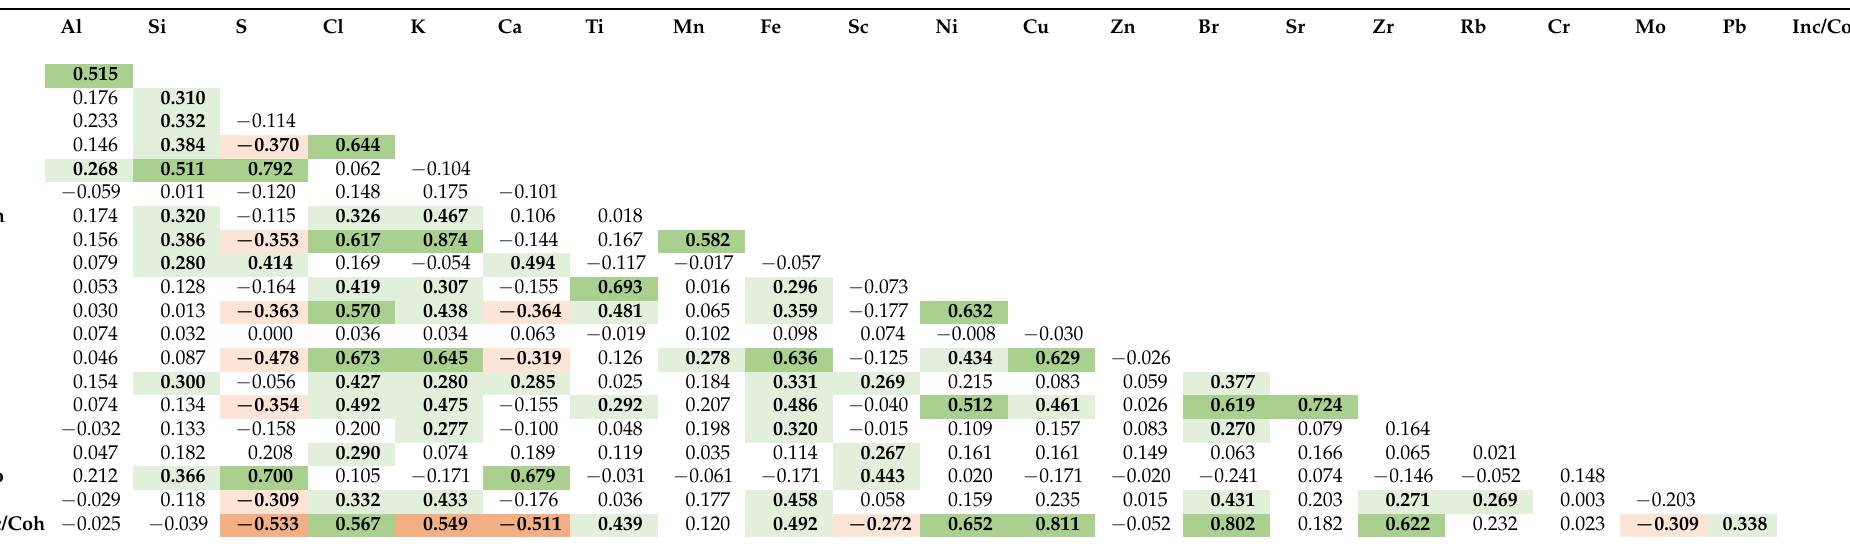
Table 4. Table displaying Pearson correlation coefficients (r) between raw element cps data detected by the XRF scanner from littoral core CHI19-4A. Dark- green-shaded cells are indicative of variables which display a coefficient of r > 0.5, whilst light-green-shaded cells indicate variables with a correlation coefficient 0.25 < r < 0.5. Orange-shaded cells highlighted with red text indicative a coefficient of r < − 0.5, whilst light-yellow-shaded cells indicate a correlation coefficient − 0.5 < r < −